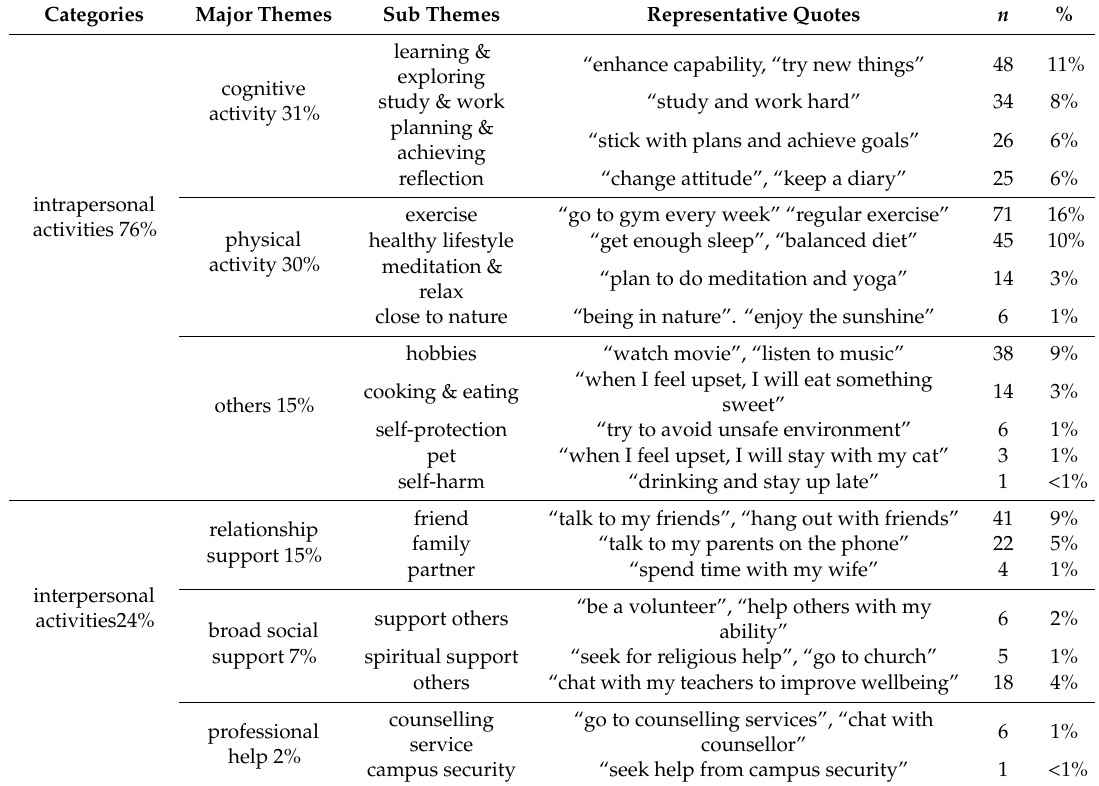
Table 3. Activities participants engage in to maintain their own wellbeing.